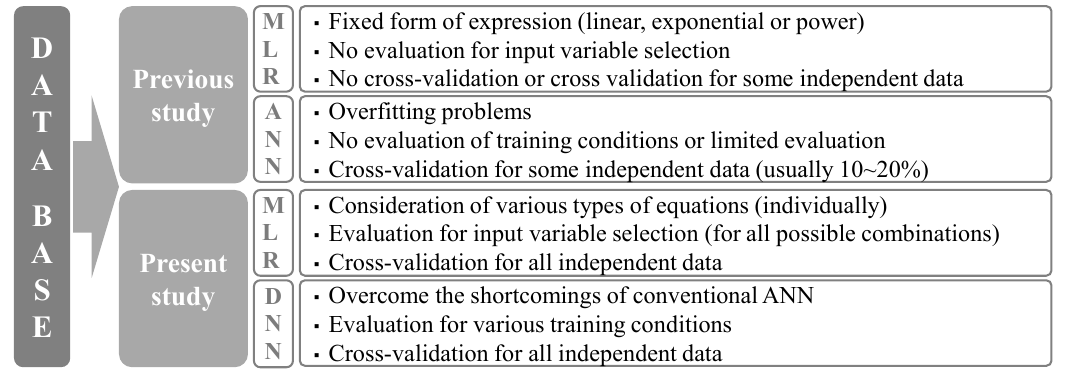
Figure 5. Comparison of modeling approaches between previous and present studies.